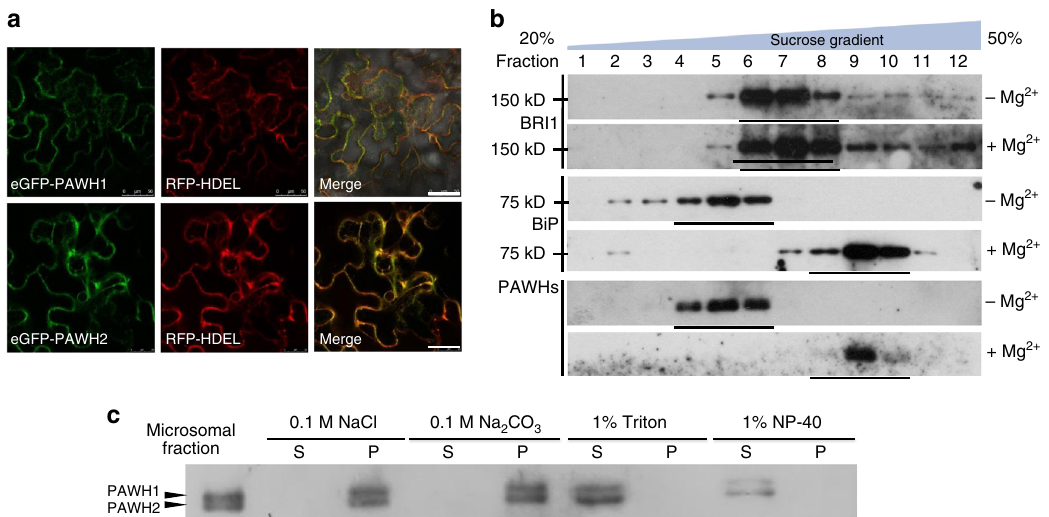
Fig. 2 PAWHs are ER membrane-anchored proteins. a The confocal microscopic images of tobacco leaf epidermal cells that transiently express GFP- PAWH1/2 (left), the ER-localized RFP-HDEL (middle), and merged images of green and red fl uorescent signals (right). Bar = 50 μ m. b Sucrose gradient ultracentrifugation of PAWH1/2 proteins/protein complexes. Protein samples from collected gradient fractions of a linear (20 – 50%) sucrose gradient in the presence ( + ) or absence ( − ) of Mg 2 + were separated by SDS-PAGE and analyzed by immunoblotting with antibodies to BRI1, BiPs, and PAWH. The positions of molecular mass standards are shown on the left. c Solubilization of PAWHs by various solvents/detergents. The microsomal preparations of 10-day-old Arabidopsis seedlings were treated with 0.1 M NaCl, 0.1 M Na 2 CO 3 , 1% (v/v) Triton X-100, or 1% (v/v) Nonidet P-40 for 4 h and centrifuged at 100,000× g for 60 min to generate both supernatant (S) and pellet (P) fractions, which were subsequently separated by SDS-PAGE and analyzed by immunoblotting with anti-PAWH antibody. Source data are provided as a Source Data fi